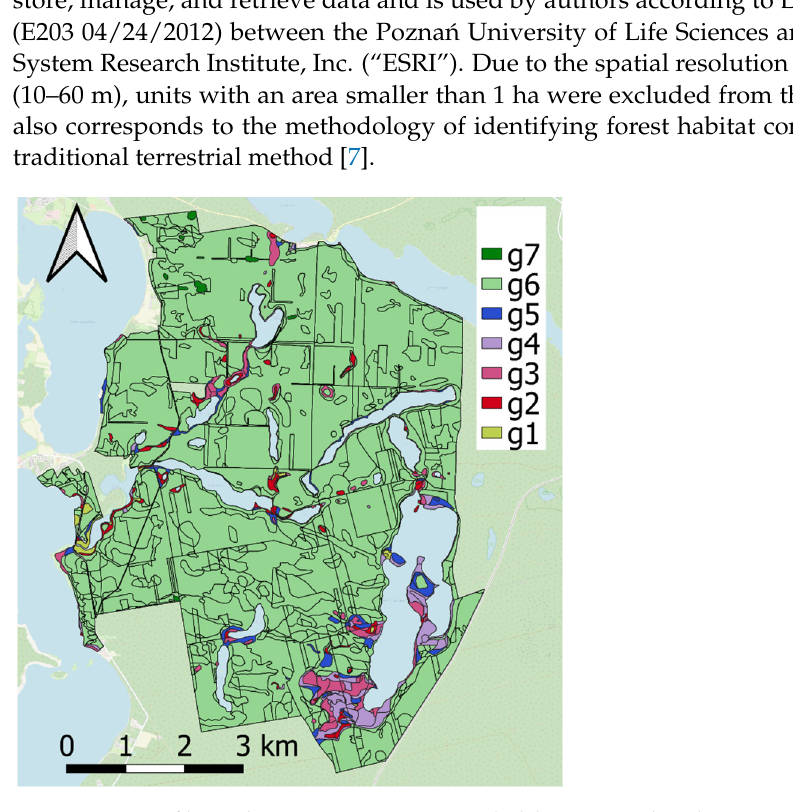
Figure 2. Map of humidity variation in Bory Tucholskie National Park, expressed in FHMIs (g1–g7) used in Poland. The explanation of g1–g7 indexes is given in the Introduction .